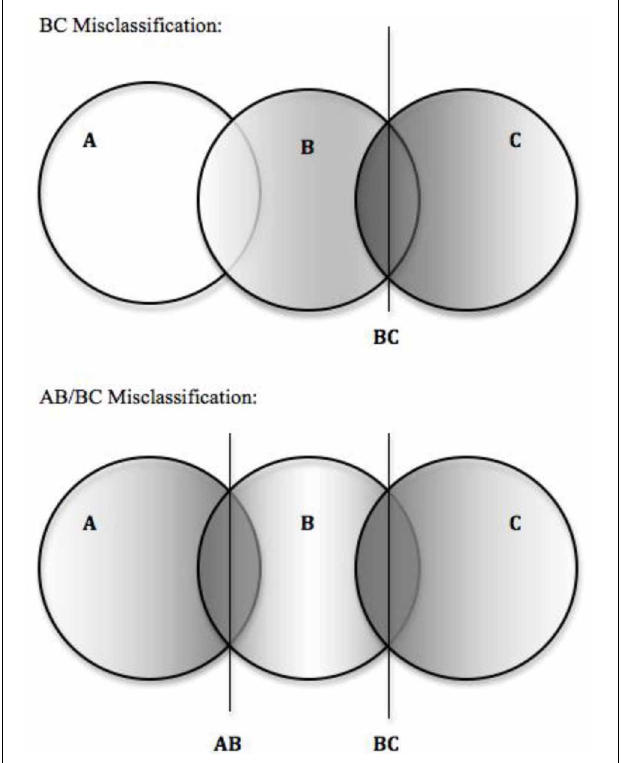
FIGURE 1 | Depiction of simulated three group misclassification situations. Note. Groups A, B, and C fall along a continuum such that ¯ X < ¯ X < ¯ X A B C . Darker shaded regions represent higher probability of